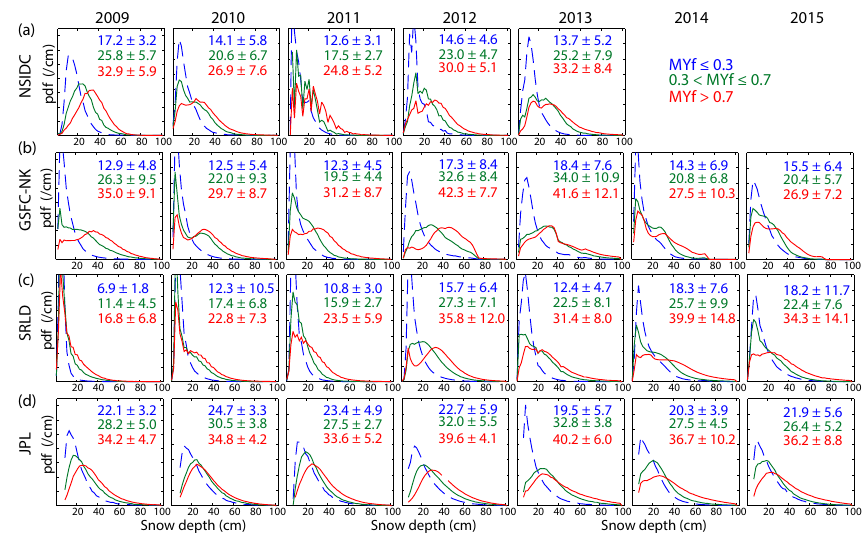
Figure 8. Snow depth distributions in 7 years (2009–2015) of retrievals: (a) NSIDC, (b) GSFC-NK, (c) SRLD, and (d) JPL. Quantities on top-right corners are the mean and standard deviation of the sample populations in three multiyear/seasonal ice regimes (MYf ≥ 0.7; 0.3 < MYf < 0.7; MYf ≤